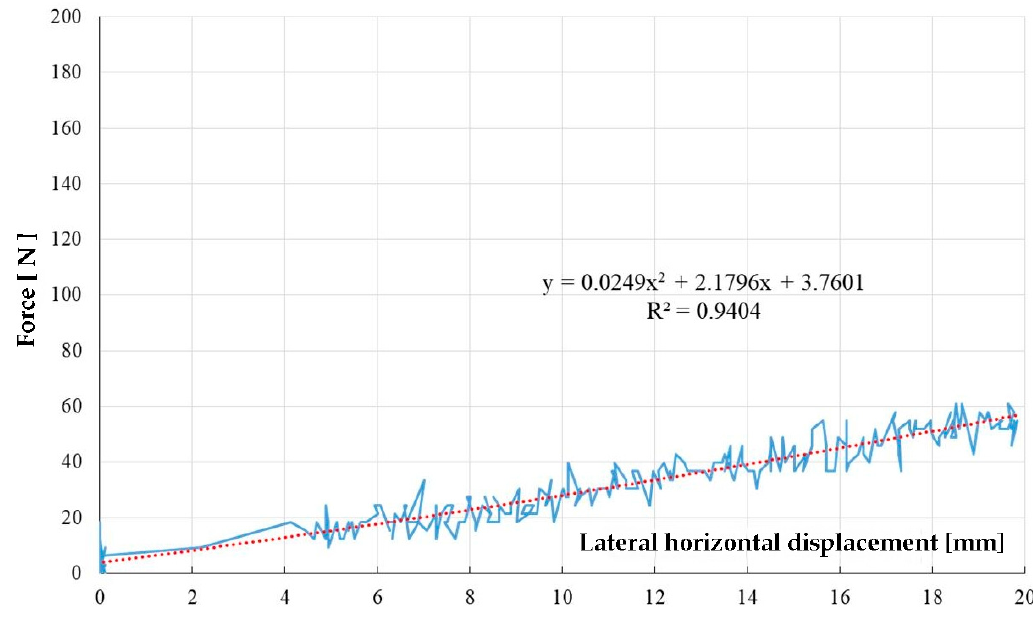
Figure 11. Force–displacement chart and approximation curve for CG1500.